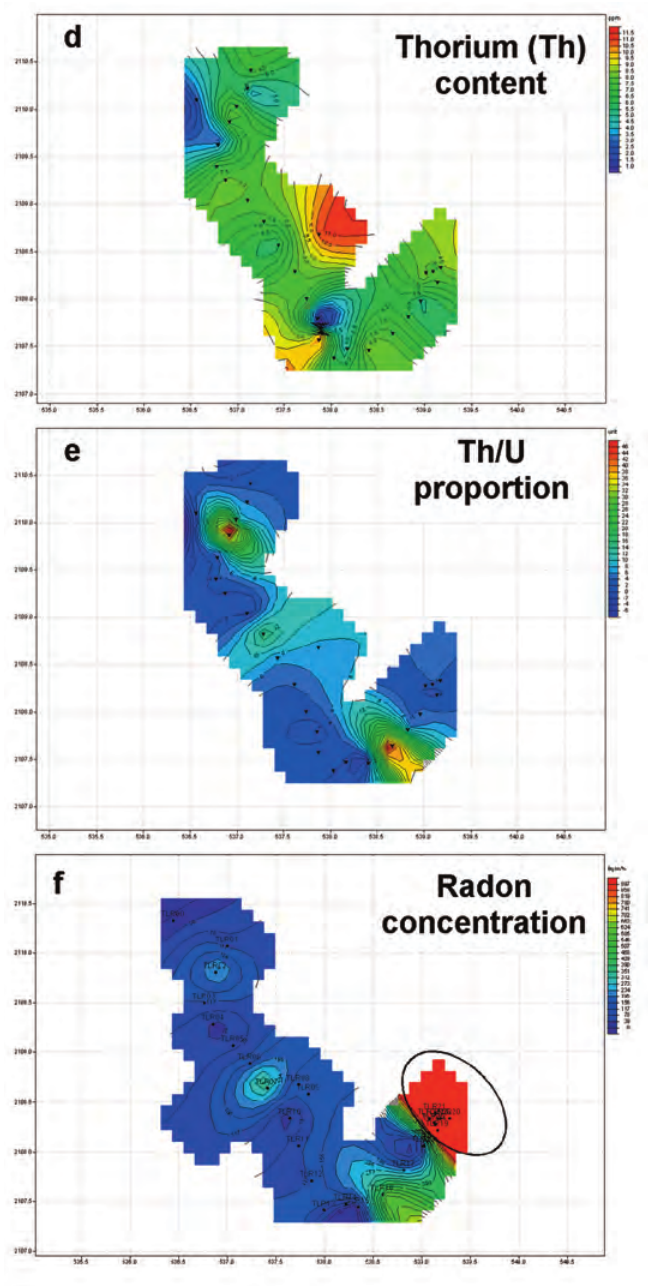
Figure 5d-f. (d) Thorium (Th; ppm) content; (e) Th/U ratio; and (f) Radon concentrations between the Tlamacas and Paso de Cortes stations (top part of the map) and in the area of Tlamacas Mountain